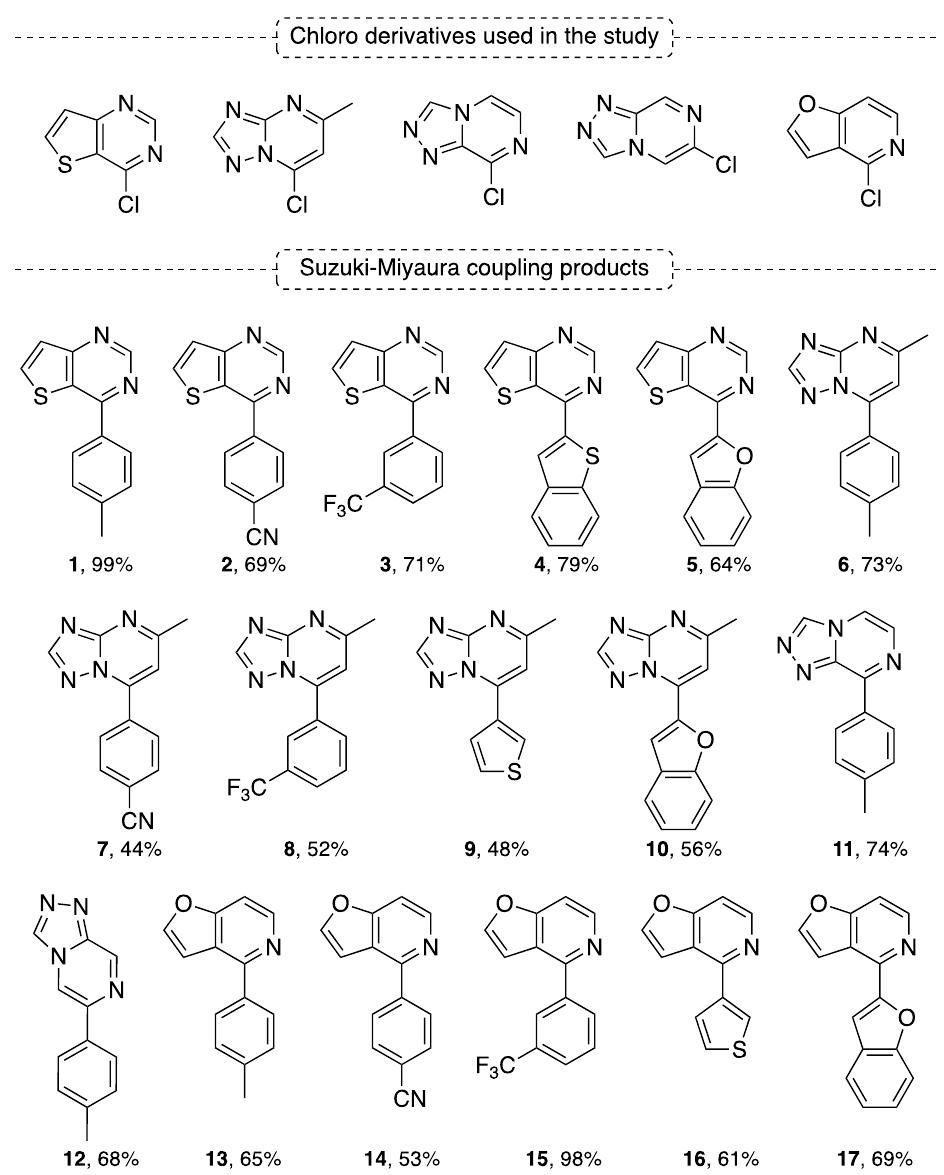
Figure 4. Suzuki – Miyaura coupling products in eucalyptol [120]. Figure 4. Suzuki–Miyaura coupling products in eucalyptol